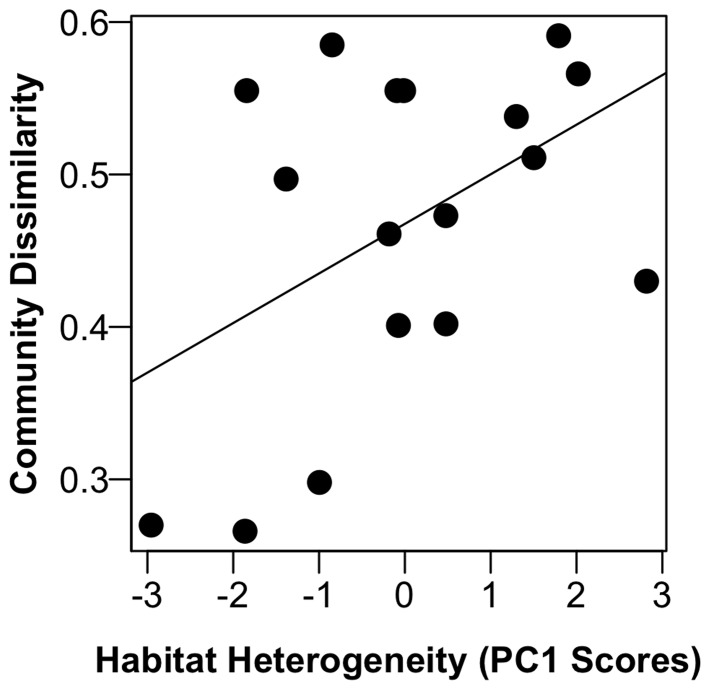
Bacterial communities were less similar among lake strata as chemical heterogeneity increased (R2 = 0.17, p = 0.05).Similarity of communities was based on the average Chao Sorensen Dissimilarity from comparisons of relative abundance of taxa among three depth strata.